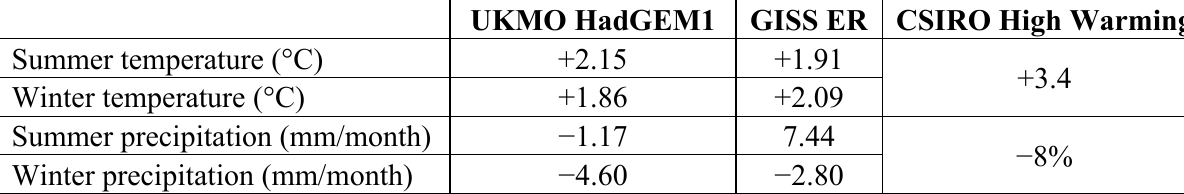
Table 10. General Circulation Models